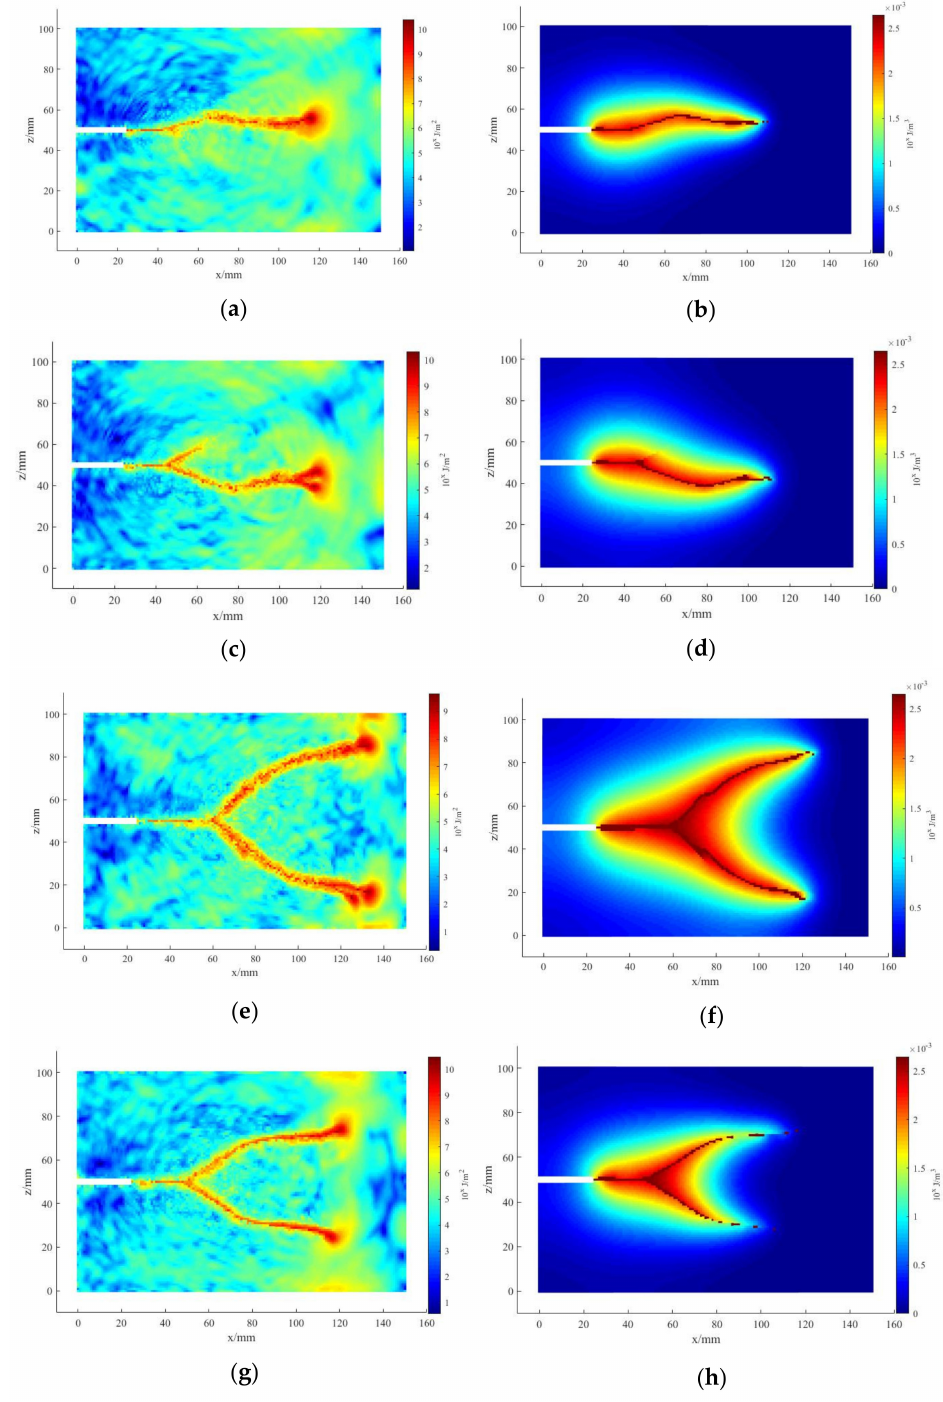
Figure 8. Energy diagram (( a ) λ B = 0.5 µ m, ( c ) λ B = 5 µ m, ( e ) λ B = 50 µ m, and ( g ) λ B = 500 µ m) and crack propagation path (( b ) λ B = 0.5 µ m, ( d ) λ B = 5 µ m, ( f ) λ B = 50 µ m, and ( h ) λ B = 500 µ m) in the liquid film thickness test at 1200 time